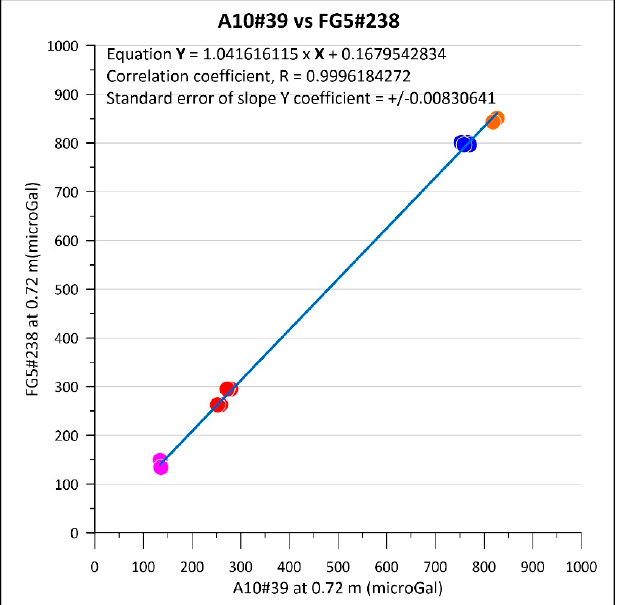
Figure 4. Linear regression between A10#39 and FG5#238 gravity values at the 5 measured stations of central Italy network over a gravity excursion of approximately 0.850 mGal (850 µGal). The used values are only the microGal part, obtained after subtracting at each station and from each single measure the common part (i.e., 980XXX000 µGal—see details in the text). Error bars are within the symbols size.